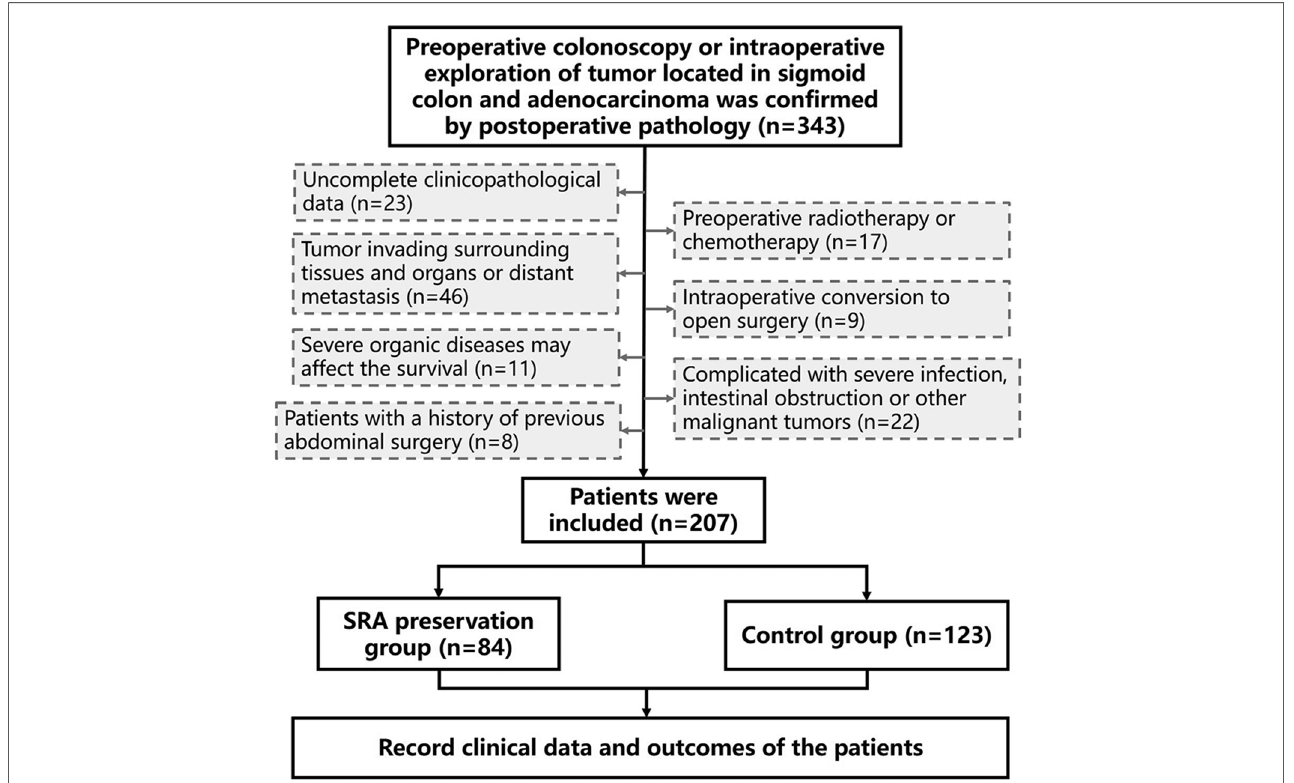
FIGURE 1 The fl owchart of the